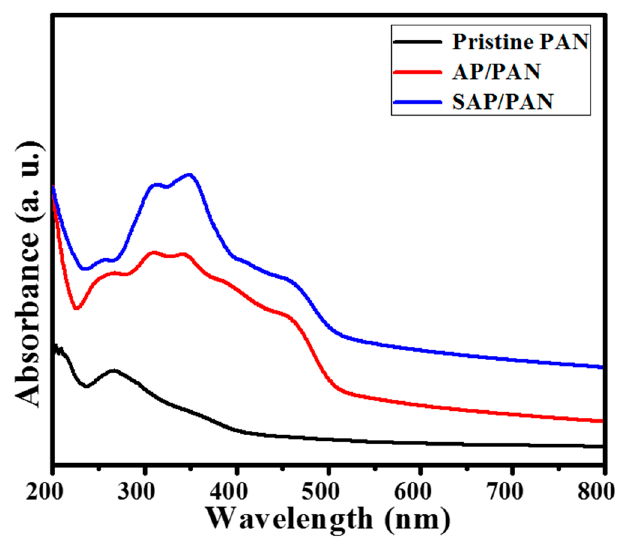
Figure 6. UV-vis di ff usive reflectance spectra of prepared Figure 6. UV-vis diffusive reflectance spectra of prepared photocatalysts.